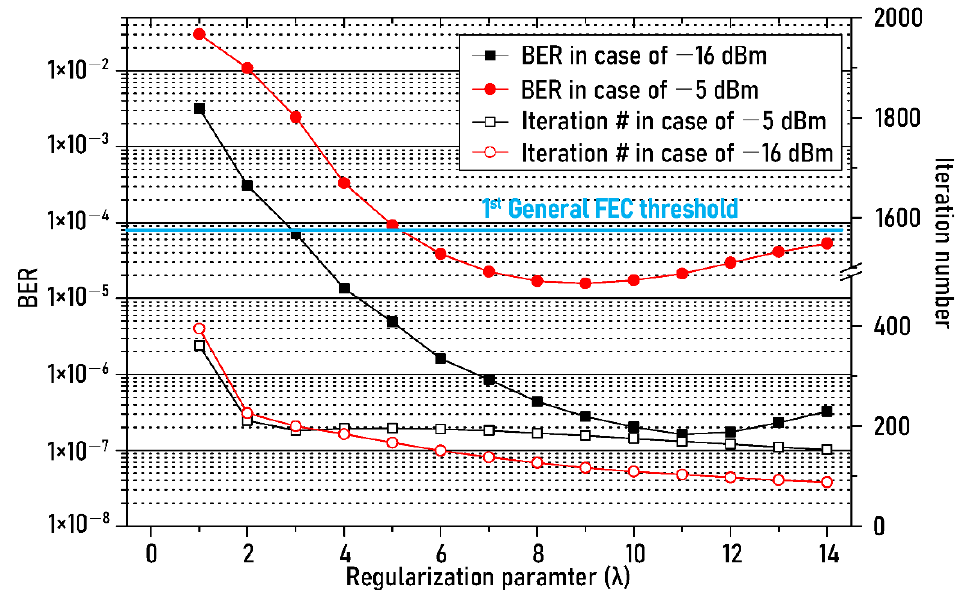
Figure 5. BER changes of recovered NRZ − OOK signal and iteration number against the regulariza- tion parameter.